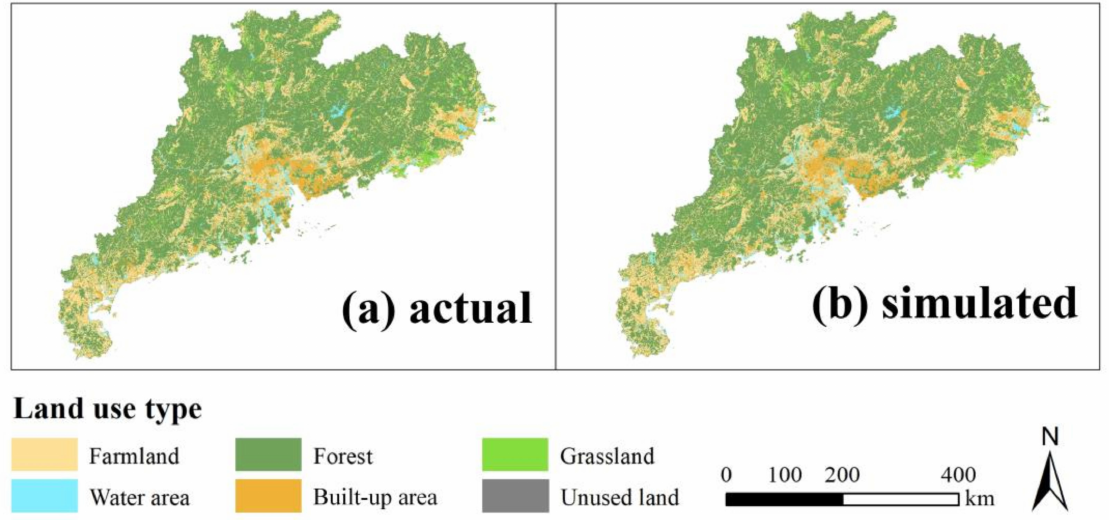
Figure 4. The comparison between ( a ) actual and ( b ) stimulated LUCC in 2020.